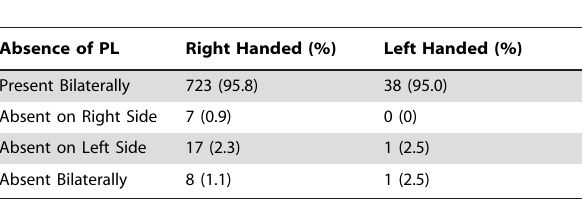
Table 2. Overall PL absence by hand dominance.